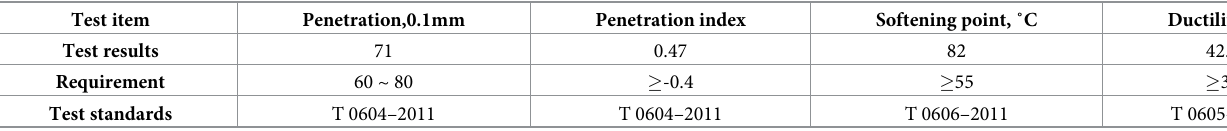
Table 1. Technical properties of the SBS-modified asphalt.